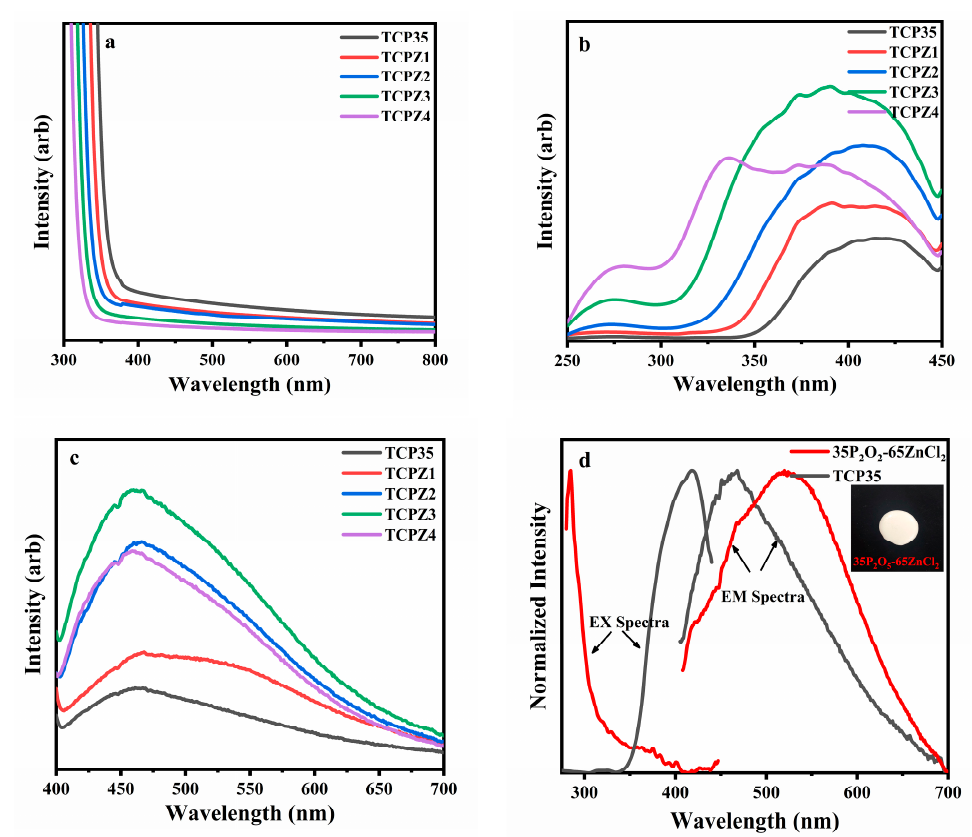
Figure 5. ( a ) Absorption spectra; ( b ) PLE spectra under 530 nm excitation; ( c ) PL spectra of TCPZ glasses under 390 nm excitation; ( d ) PLE-PL spectra of TCP35 and 35P 2 O5-65ZnCl 2 glasses. The inset is the physical image of binary P-Zn glasses.